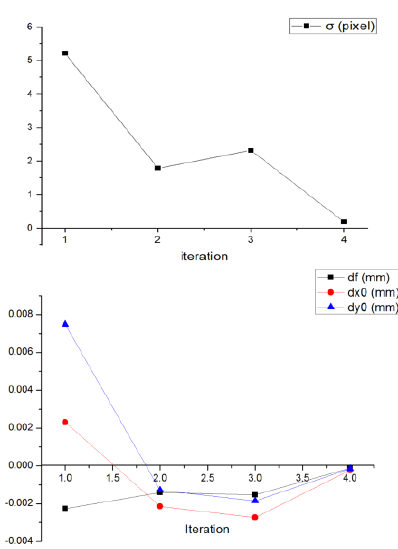
Figure 4. Changes of σ and the corrections of interior orientation parameters of Trial B .